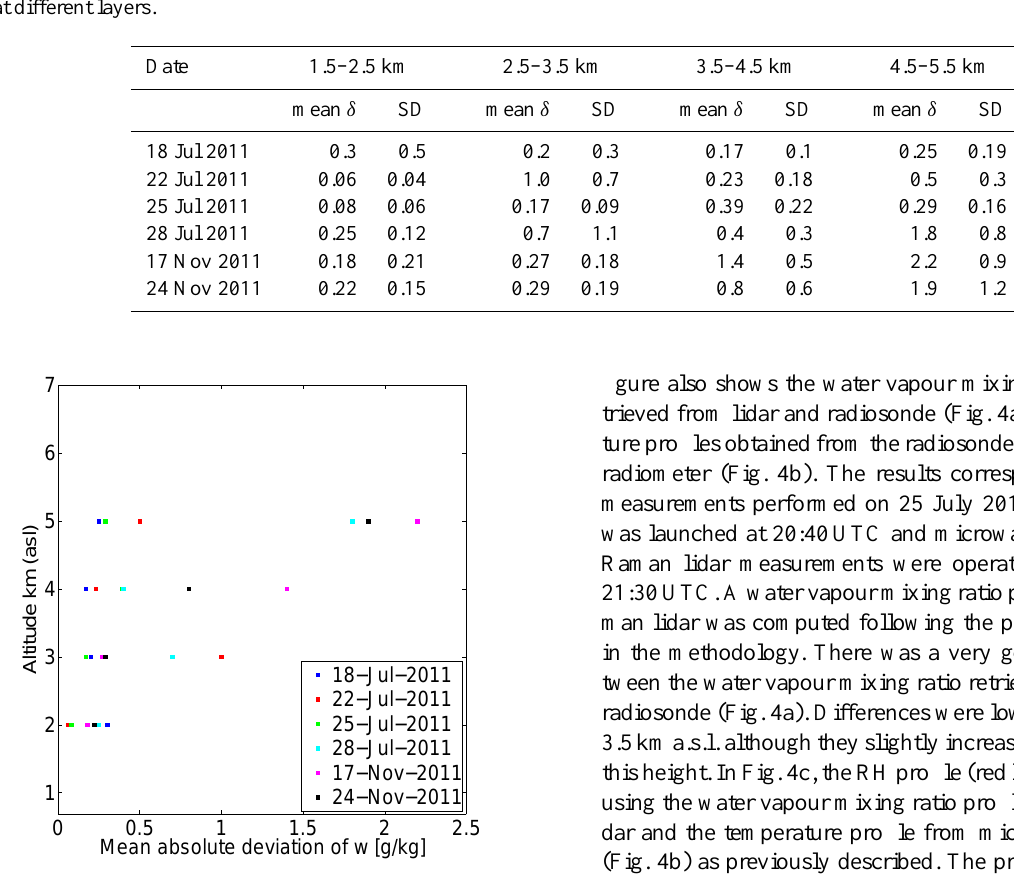
Fig. 3. Mean absolute deviation of water vapour mixing ratio be- tween lidar and radiosondes.